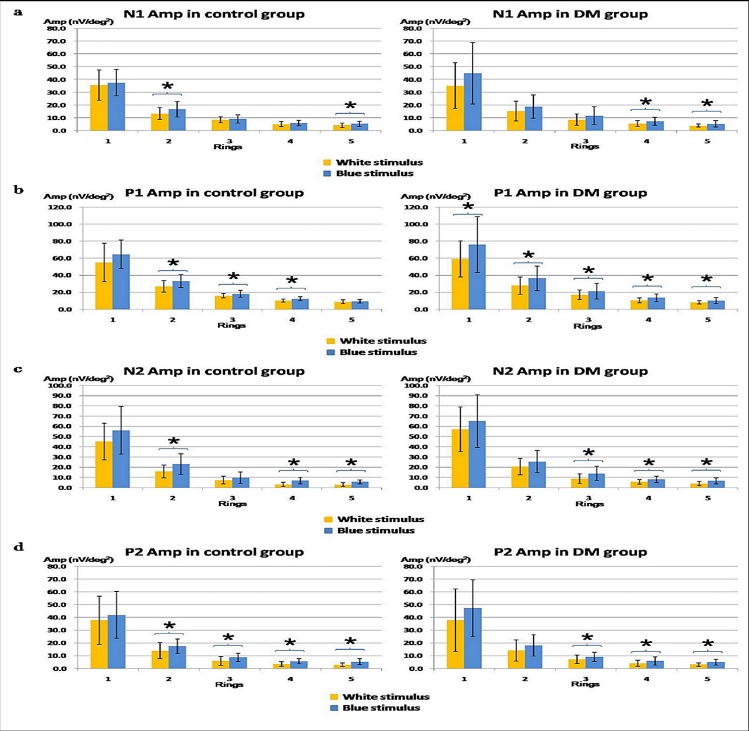
(a) The N1 amplitude (mean ± SD) in the DM and control groups under both the white and blue conditions; (b) The P1 amplitude (mean ± SD) in the DM and control groups under both the white and blue conditions; (c) The N2 amplitude (mean ± SD) in the DM and control groups under both the white and blue conditions; (d) The P2 amplitude (mean ± SD) in the DM and control groups under both the white and blue conditions (* indicates parameters that achieved statistically significant level with p < 0.05)